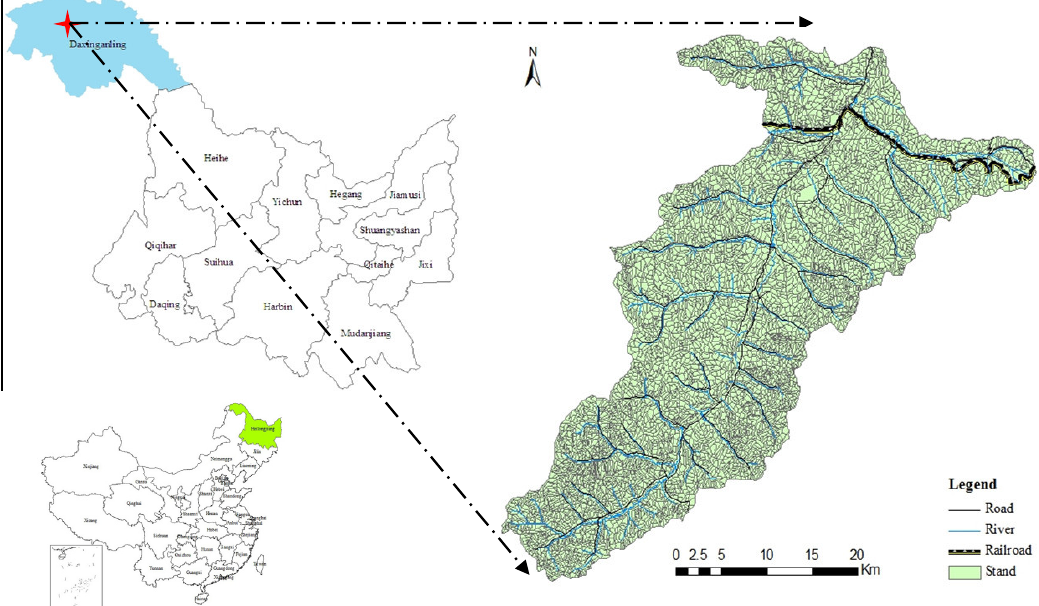
Figure 1. Study area of Pangu forest farm in Heilongjiang Province, northeast China.